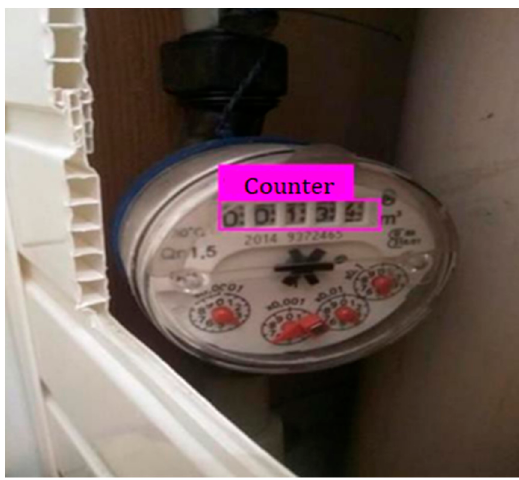
Figure 10. Object detection result.